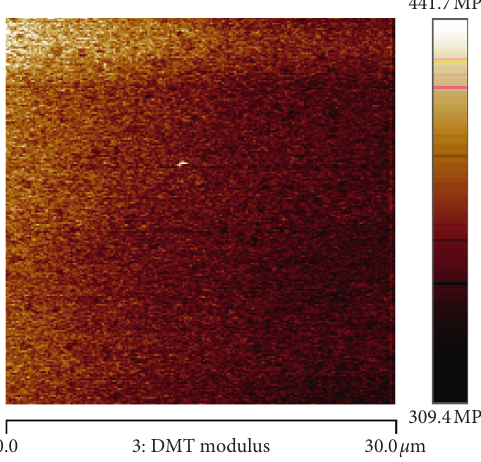
Figure 7: Nanomorphology of #70 matrix asphalt +30% pre- activated Buton rock powder.